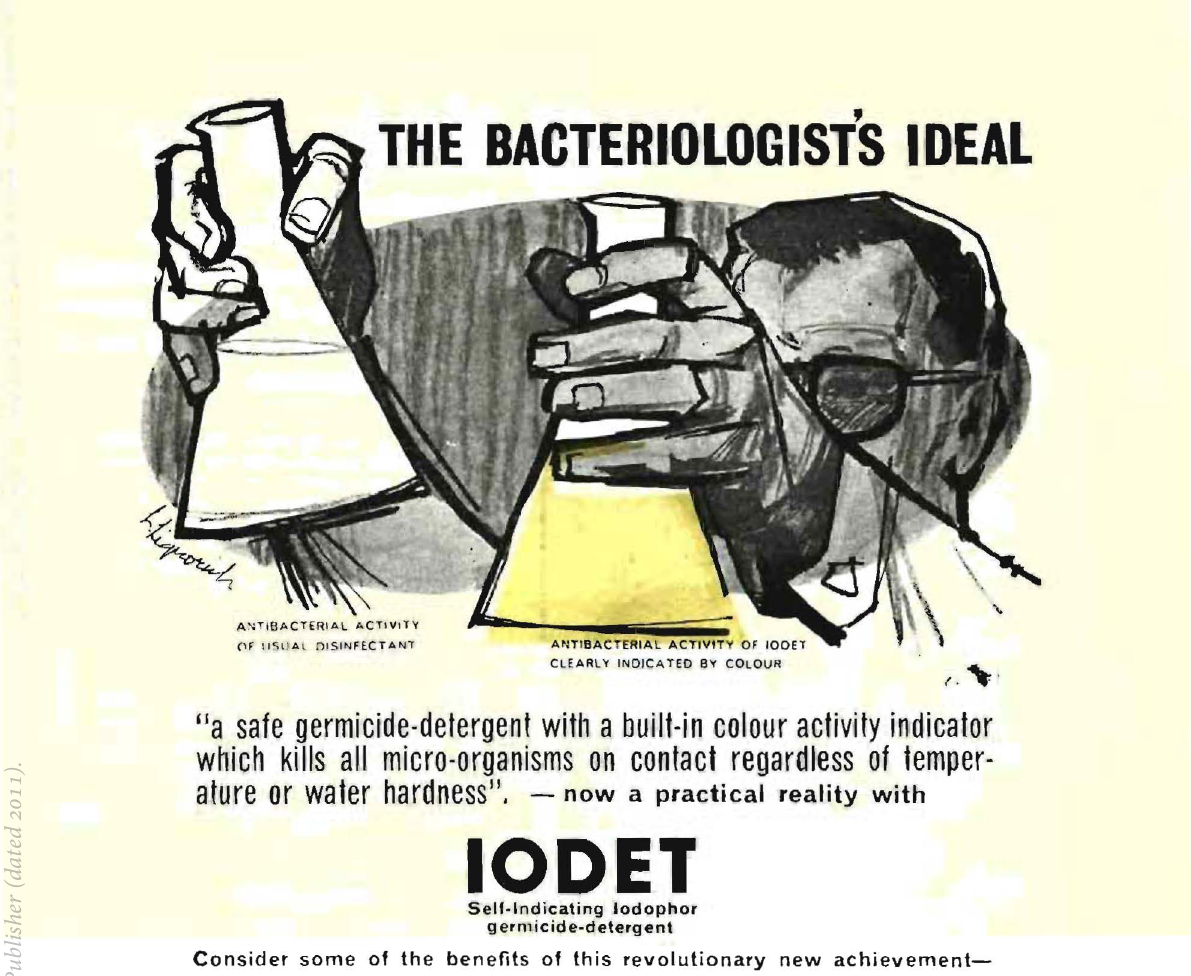
IODET Self-Indicating Iodophor g e,micide-dete,gent Consider some of the benefits of this revolutionary new achievement- , Non-slaining built-in colour aclivity indi cator takes the guesswork oul 01 vital sani tizing procedures. 'Detergent action rapidly removes dirt. 'Biocidal aclivity rapidly kills micro-organ isms including bacteria, viruses, lungi, algae and protozoa in a lew seconds al all lem peratures, regardless of waler